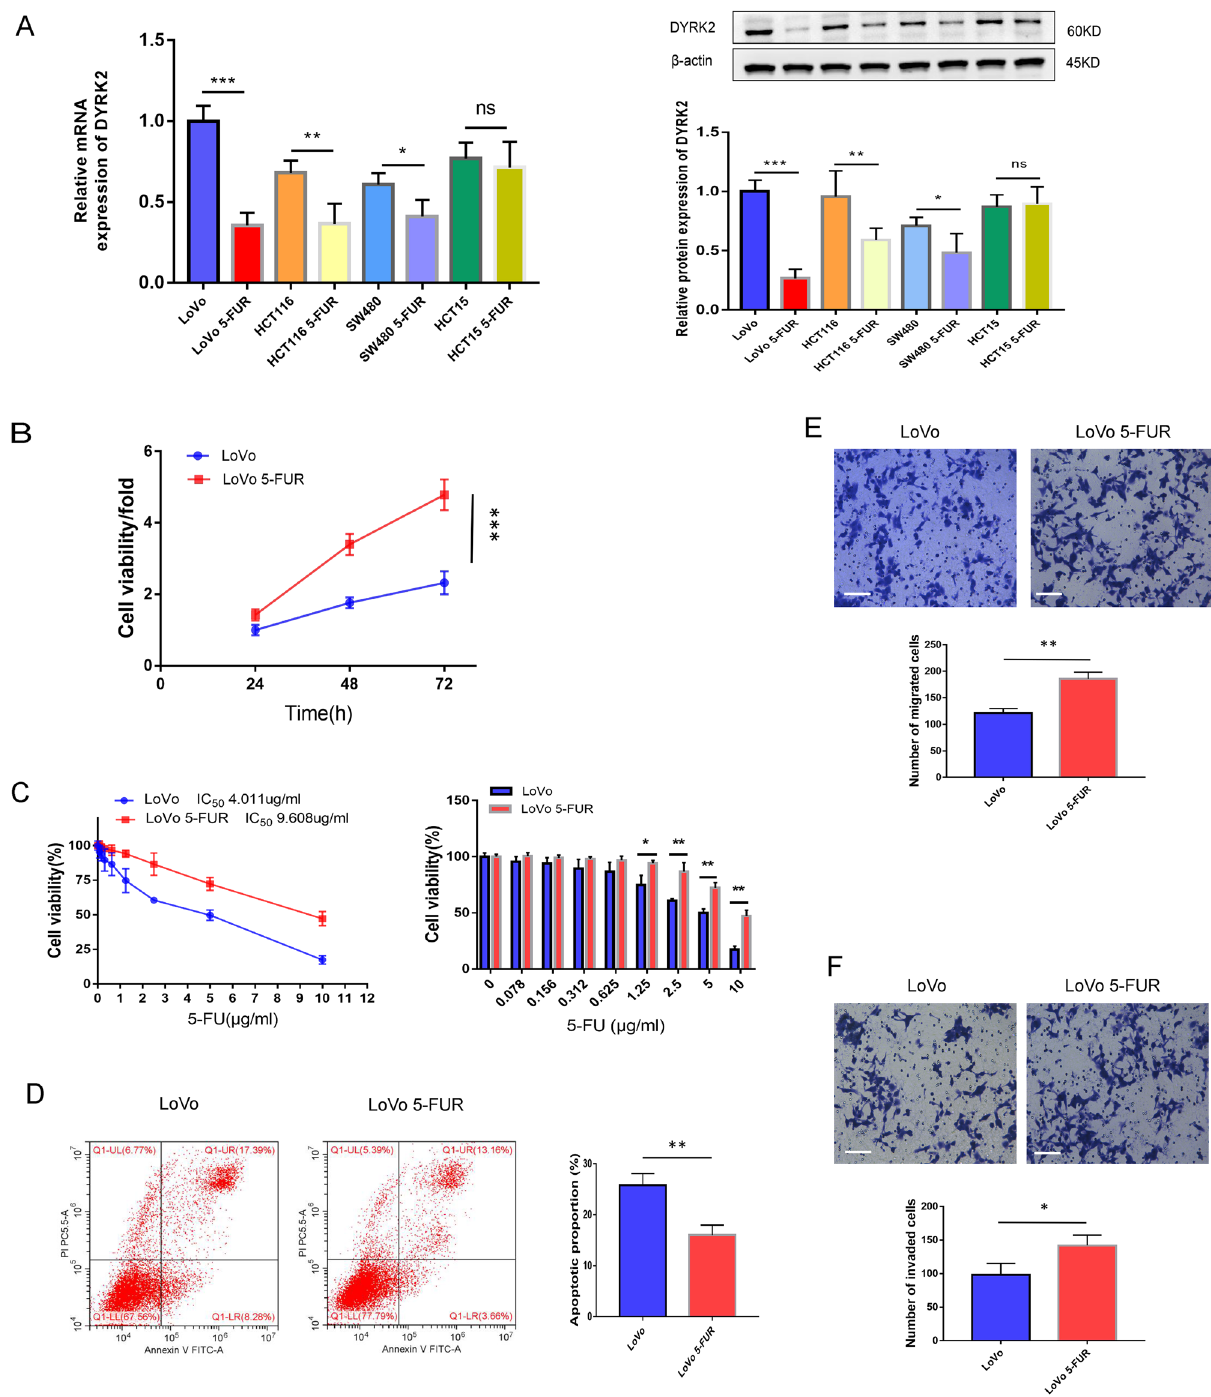
Figure 2. Low levels of DYRK2 expression are associated with enhanced malignancy in 5-FUR LoVo cells. ( A ) Western blotting and qPCR were performed to detect DYRK2 expression in different CRC lines and 5-FU resistant cells. ( B – D ) Cellular proliferation, chemosensitivity, and apoptotic death were assessed for both LoVo and 5-FUR LoVo cells via CCK-8 assays and flow cytometry. ( E , F ) LoVo and 5-FUR LoVo cell migratory and invasive activity levels were assessed via Transwell assays. Scale bar = 50 μm (× 200). Data are expressed as mean ± SD (n = 3). * P < 0.05, ** P < 0.01, *** P <